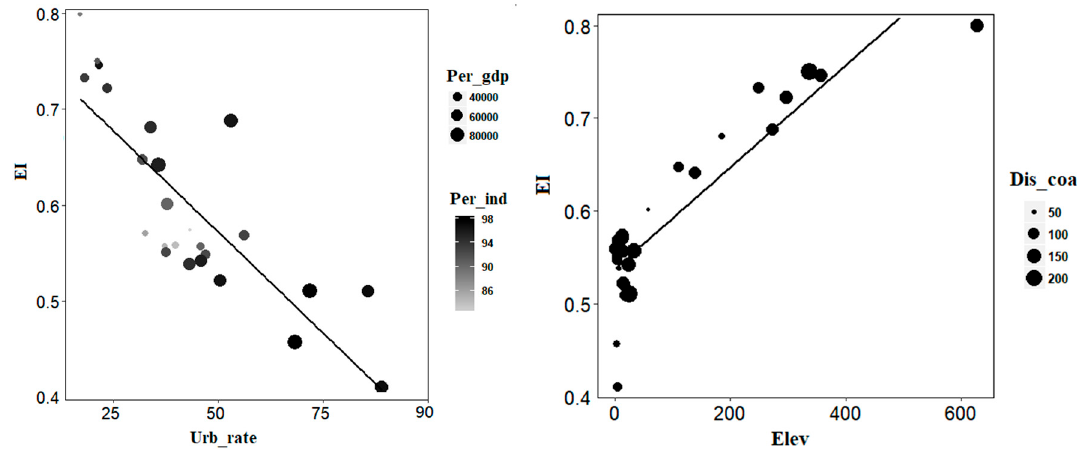
Figure 6. Relationship of EI with natural conditions and human activities in 2010. Eco_C: Ecological conditions; Urb_rate: Urbanization rate (%); Per_gdp: Per capita GDP (CNY); Per_ind: Percentage of secondary and tertiary industry employment (%); Elev: Elevation differentiation (m); Dis_coa: Land sea gradient (km).